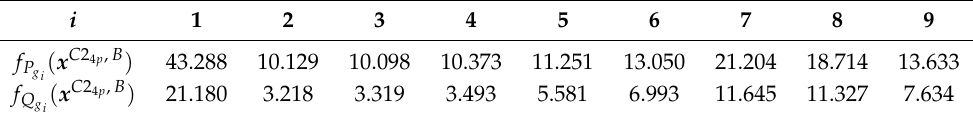
Table 8. Values of the 18 indices produced by x C 2 4 p , B